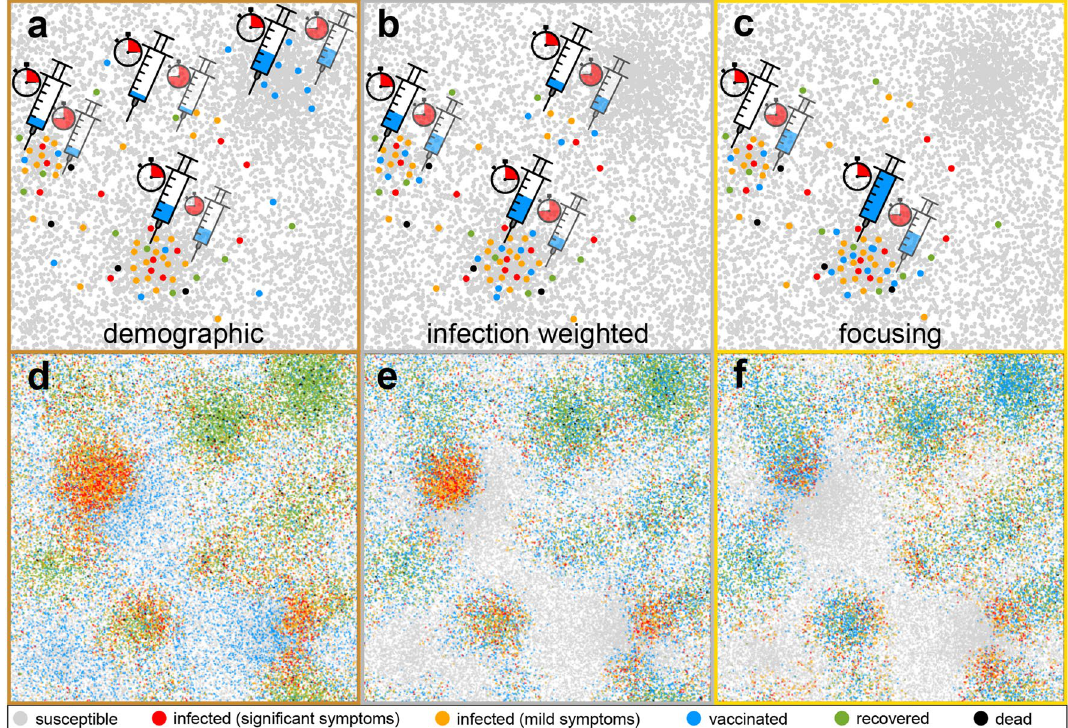
Figure 1. Schematic illustration of the proposed spatiotemporal vaccine distribution strategies and of the simulation model. ( a ) shows the standard “demographic strategy”, where vaccines (dosage needles) are continuously distributed among all regions (e.g. cities) proportionally to their population density (dots represent groups of individuals). ( b ) shows the “infection weighted” strategy, where vaccines are distributed proportionally to the local bi-linear incidence rates (red and orange dots) and ( c ) shows the “focusing strategy” where at early times (clocks; transparent syringes show the vaccine distribution at later times) only the region with the largest bi-linear incidence rate receives vaccines, until the rate of a second region catches up and also receives vaccines. ( d )–( f ) show typical simulation snapshots for an inhomogeneously distributed population with a “city size distribution” following Zipf’s law, taken 56 days after the onset of vaccination when following the demographic strategy, the infection weighted strategy or the focusing strategy, respectively. The legend below shows the states in our